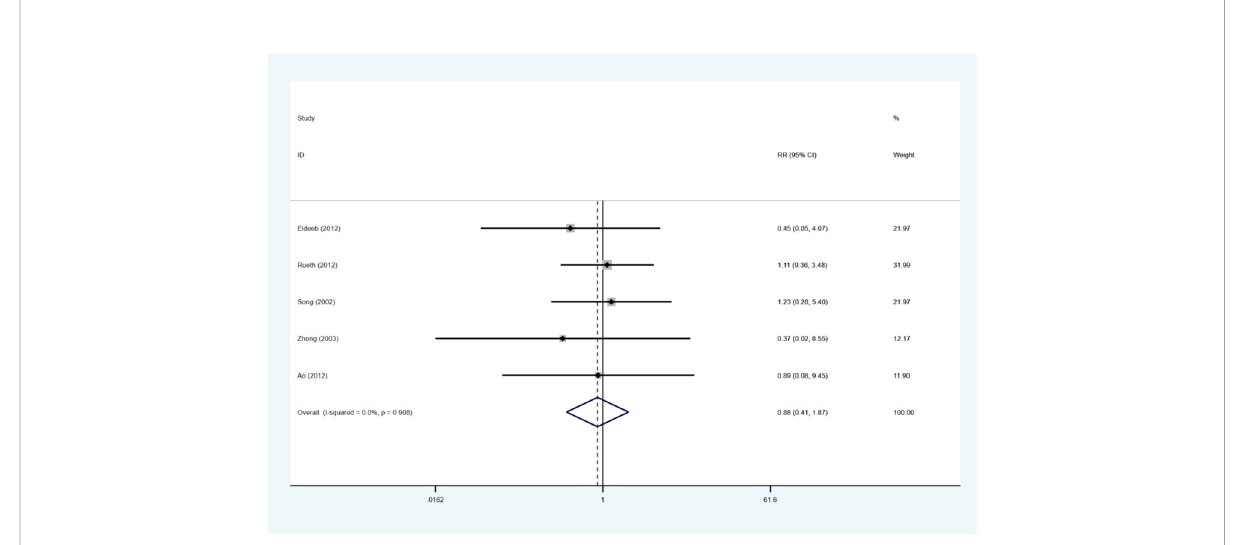
FIGURE 7 Forest plot for the results of stent